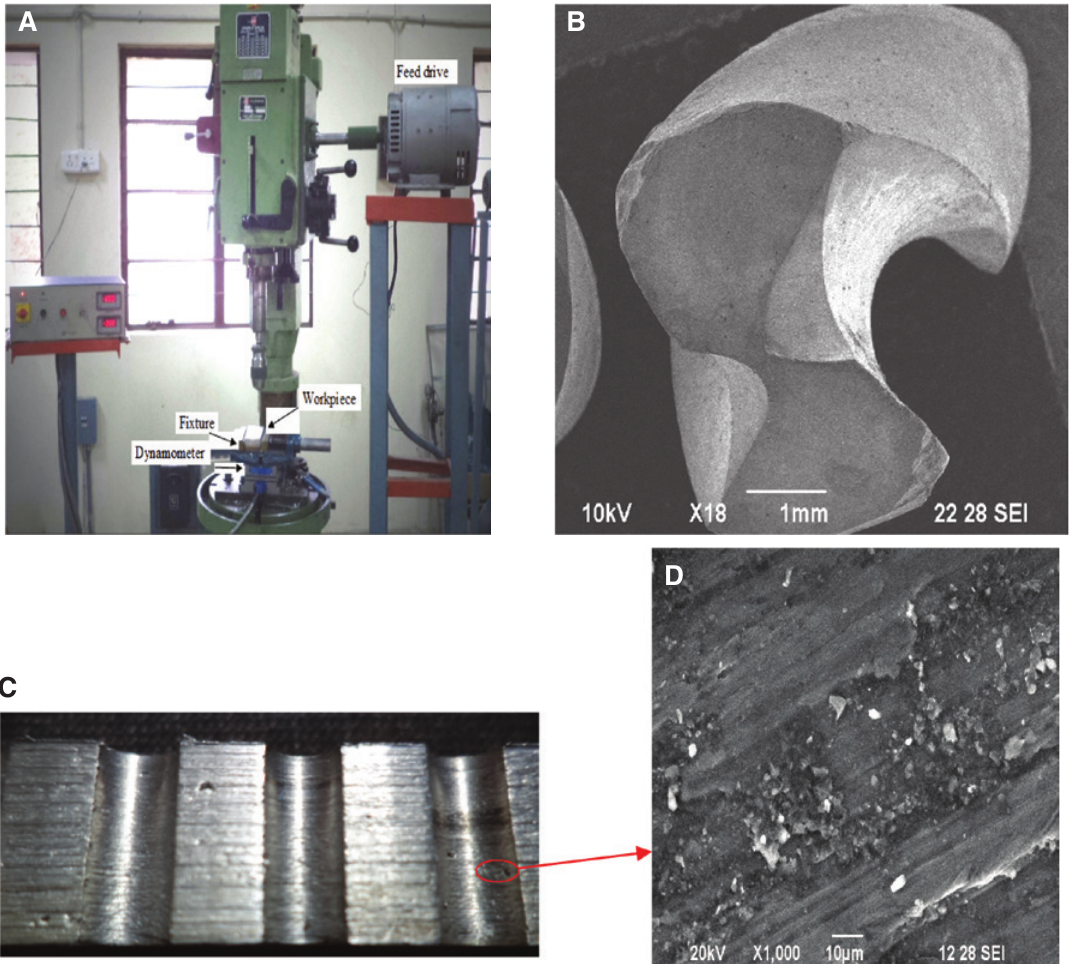
Figure 5: (A) Experimental set-up for thrust force and torque measurement, (B) SEM of the worn carbide drill bit at spindle speed = 1260 rpm and feed = 0.03 mm/rev, (C) cross-sectional view of the drilled hole of sample 2, and (D) SEM image of the drilled hole using carbide drill at spindle speed = 1260 rpm and feed = 0.03